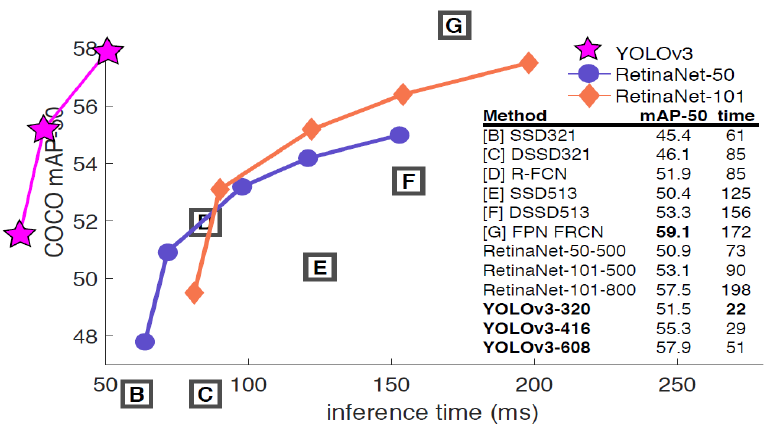
Fig. 21. Performance comparison of object detection